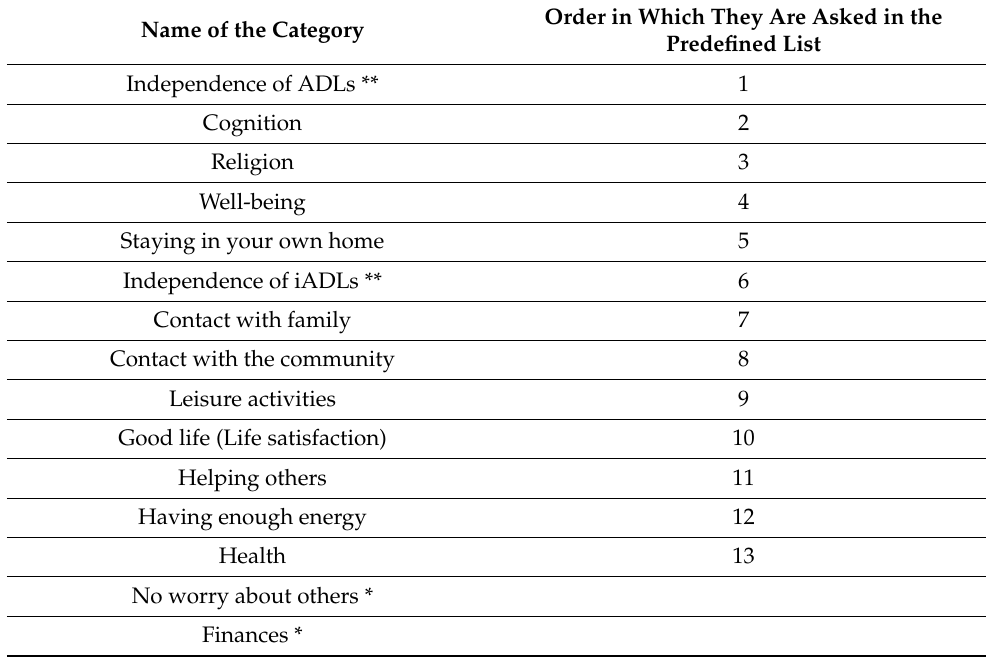
Table A1. List of Categories to Classify the Open-Ended Answers. Name of the Category